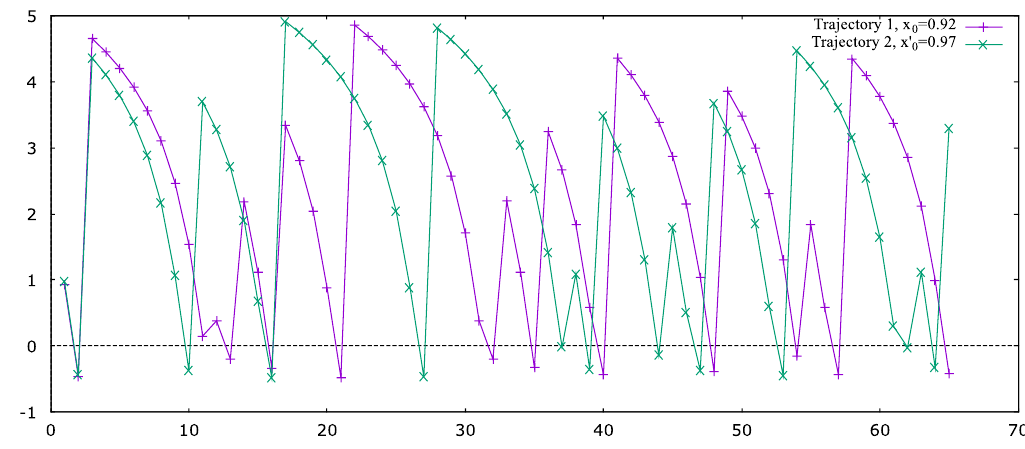
Figure 10. Two trajectories of two nearby initial values